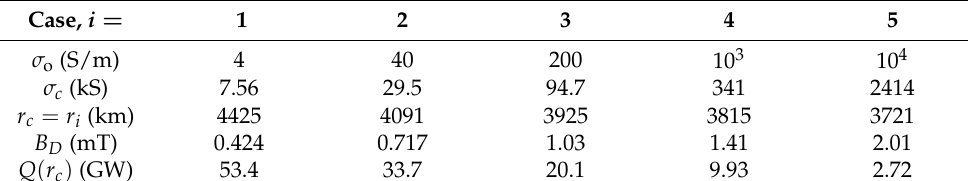
Table 1. Model properties for five cases with different σ o . The associated σ c and radii r c = r i , i = 1, . . . ,5 in Figure 1 are given here, along with estimated values of heating rate Q ( r c ) and rms dipole magnetic intensity B D at the CMB. For comparison, the Mauersberger–Lowes values for B D are 0.0422 mT on the Earth’s surface and 0.259 mT on the CMB. (Conduction in the mantle starts at r s = 5371 km and finishes at the CMB at r o = 3480 km; its effects are modeled as due to a spherical surface current of conductance σ c at r = r c .)